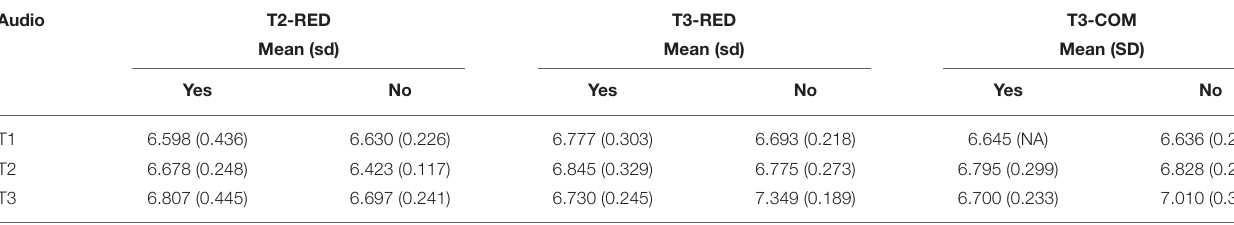
TABLE 4 | Mean RTs and SDs in each condition.